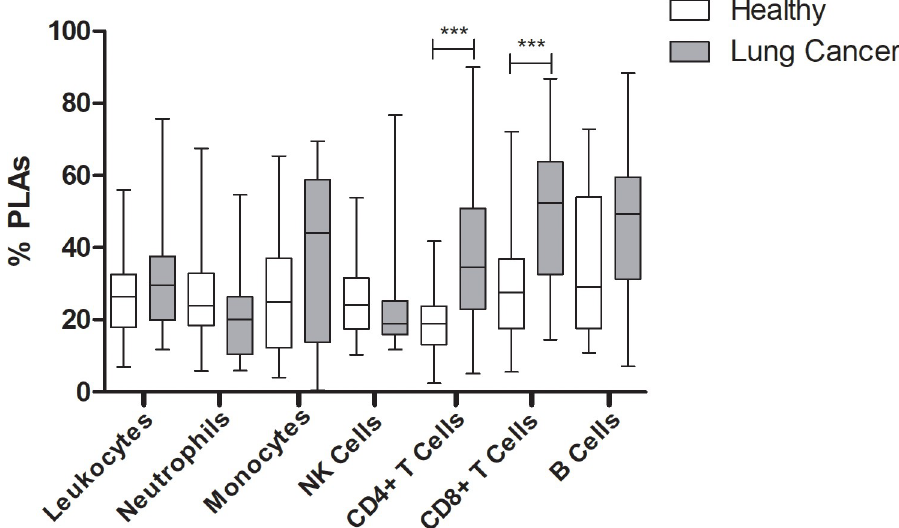
Fig 1. Platelet-leukocyte aggregates in lung cancer patients compared to healthy volunteers. (A) Whole blood from healthy volunteers (white) or lung cancer patients (gray) was labeled with markers for leukocytes (anti-CD45), neutrophils (anti-CD66B), monocytes (anti-CD3 negative, anti-CD14+), natural killer cells (anti-CD56), CD4+ T cells (anti-CD4), CD8+ T cells (anti-CD8), or B cells (anti-CD19). Samples were co-labeled with APC-conjugated anti- CD42b. Mann Whitney nonparametric test. ��� p �